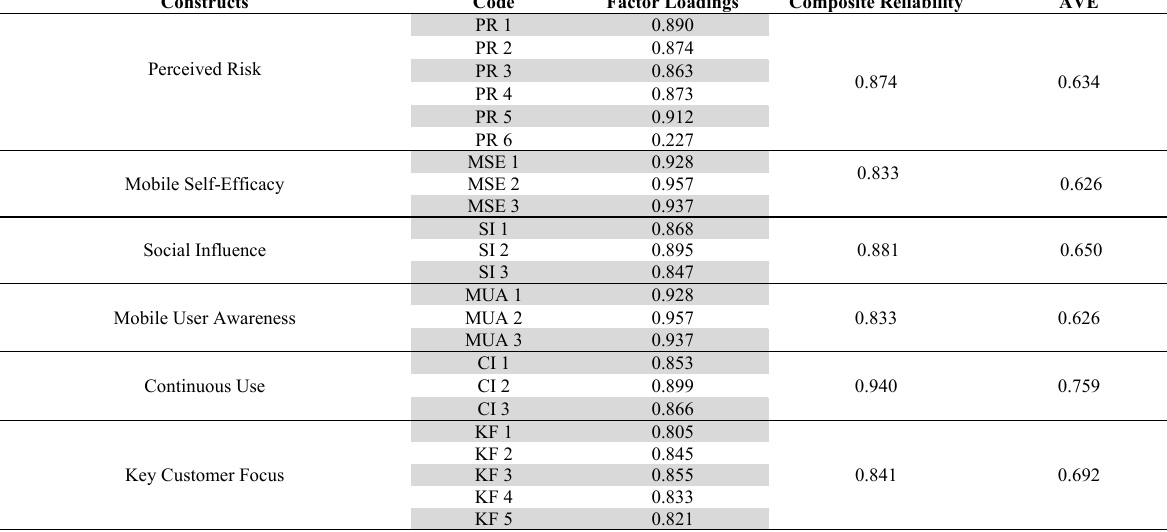
Factor Loadings and Construct Validity and